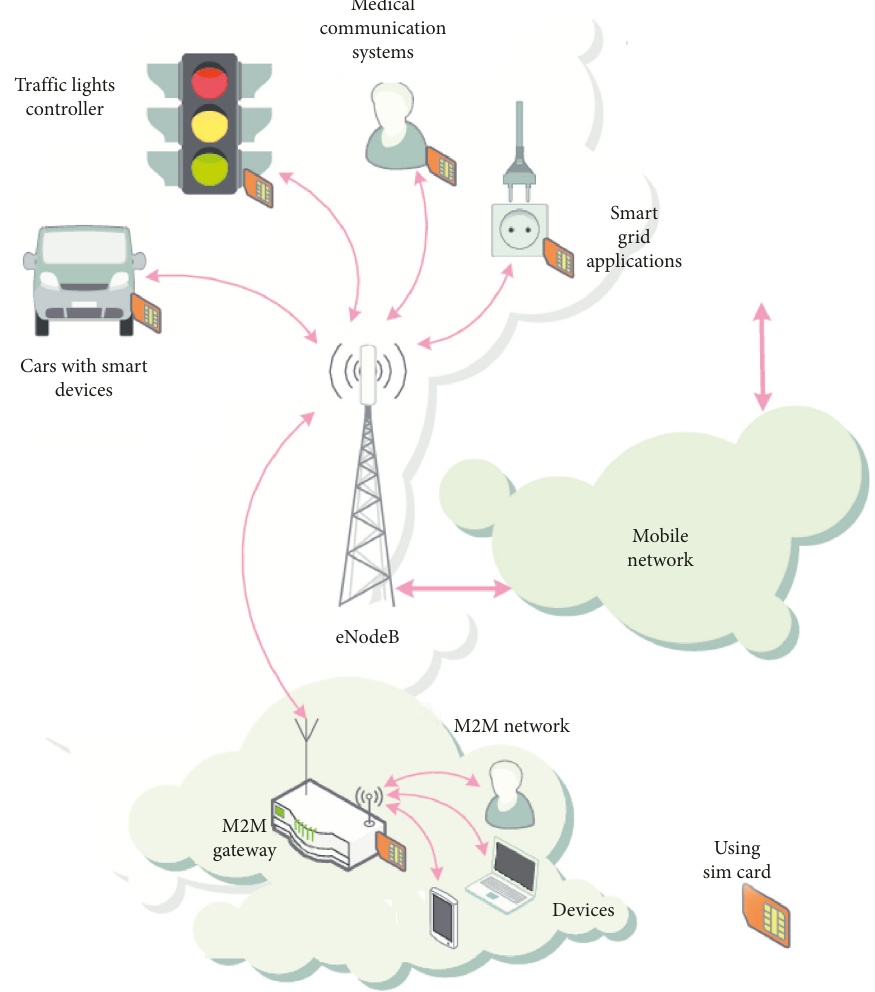
Figure 1: Smart communication system with M2M network, smart grids, and possible cellular